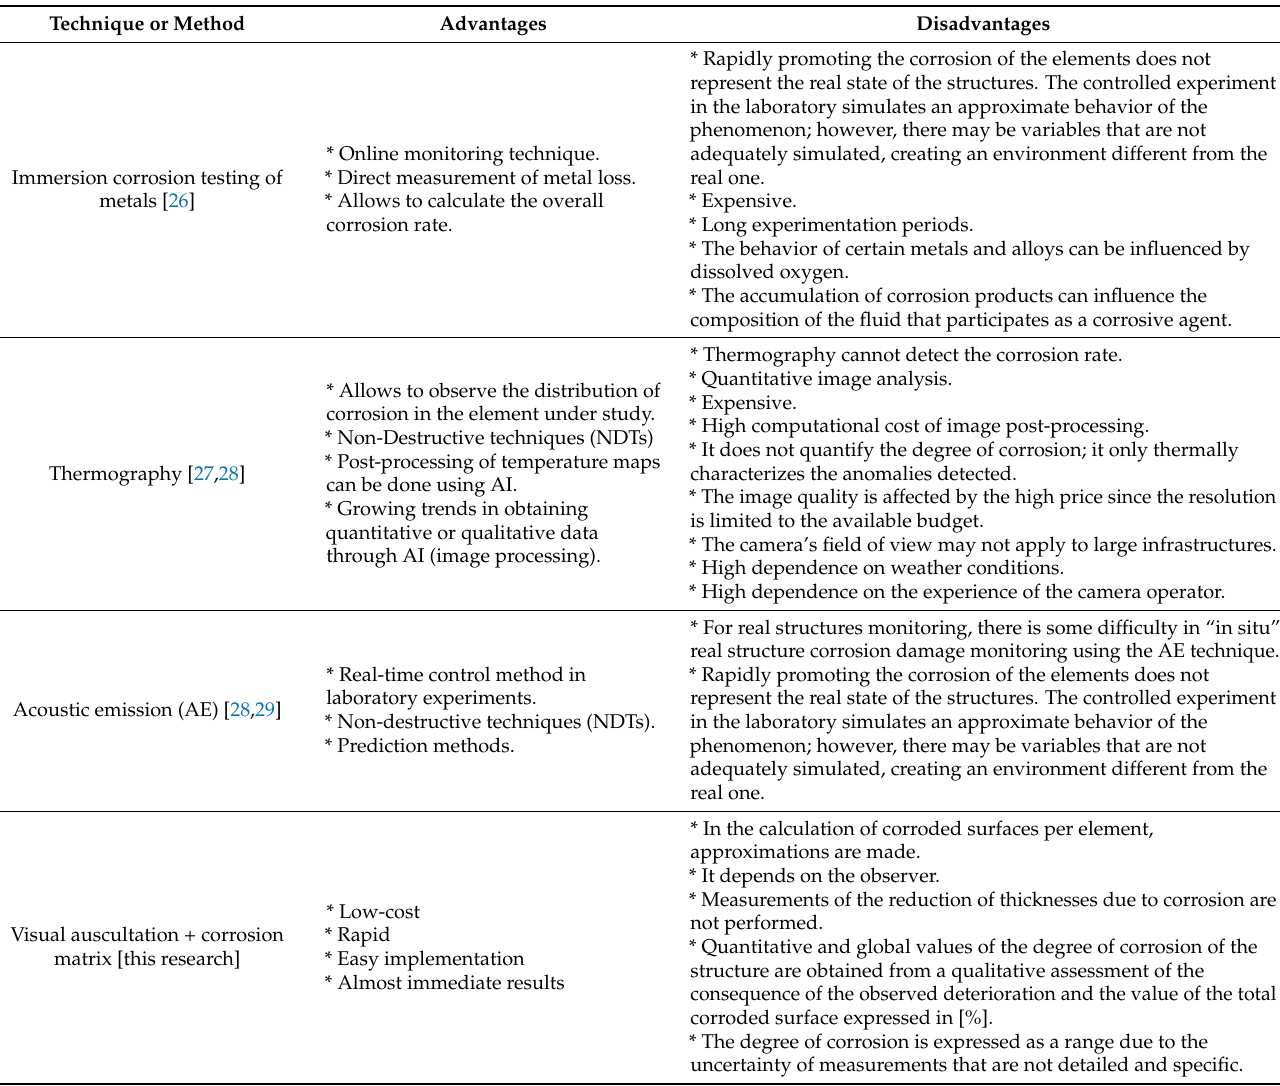
Table 2. Current methods for corrosion degree